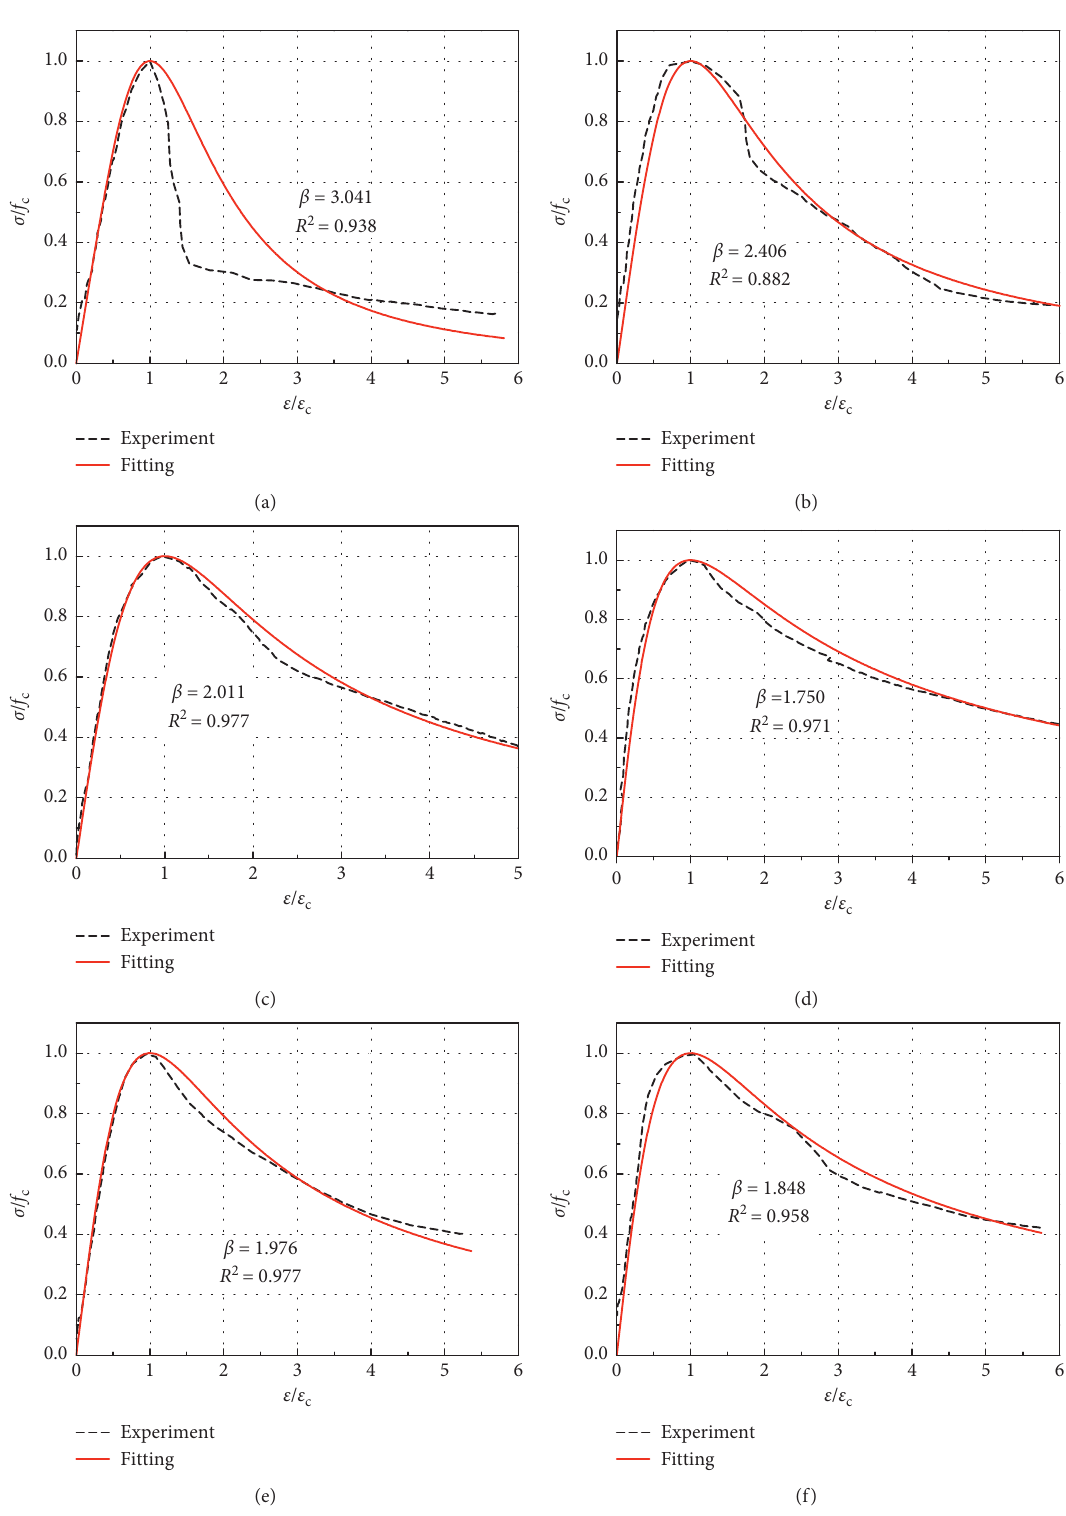
Figure 15: Comparison of the fitting curve and experiment curve. (a) CR5SF0. (b) CR5SF0.5. (c) CR5SF1.0. (d) CR5SF1.5. (e) CR5SF1NS1. (f)